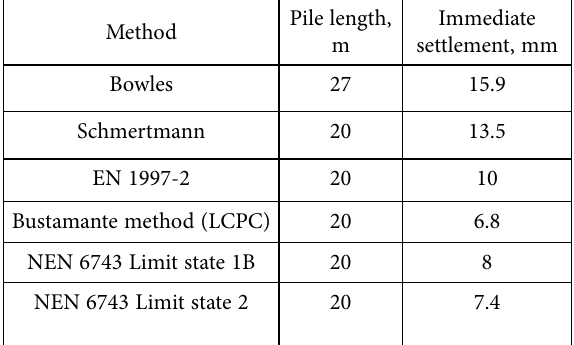
Table 7. A comparison of pile settlement results obtained using different